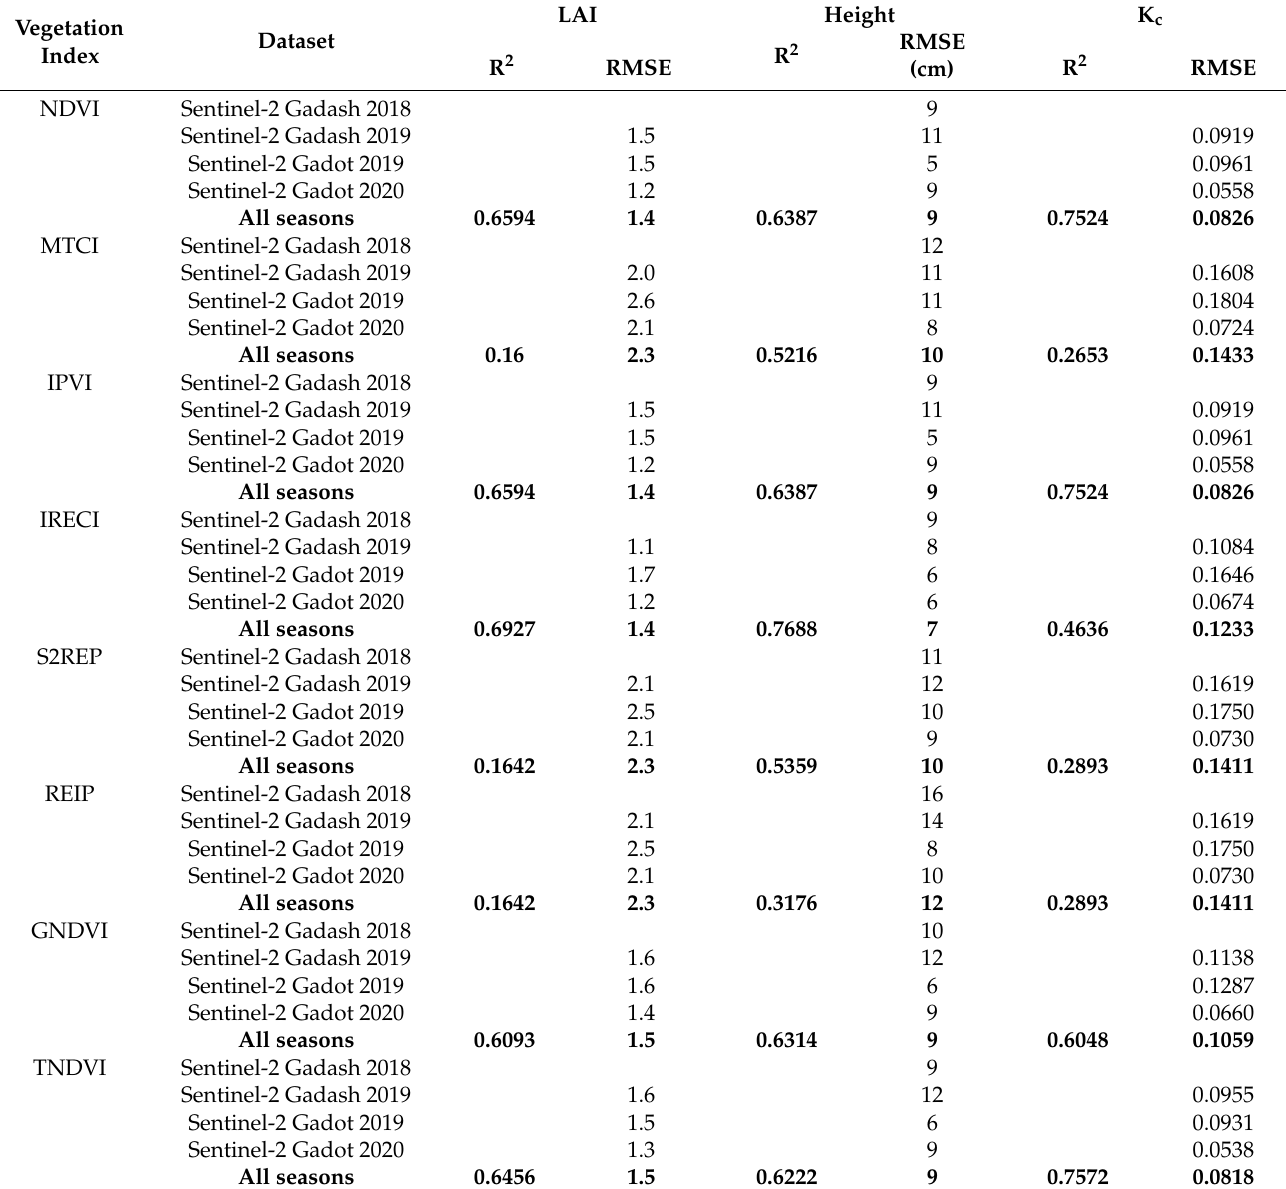
Table A2. Performance statistics of newly developed Sentinel-2-based LAI, Height, K c models, and the performance of the SNAP biophysical processor LAI estimation algorithm. Performance statistics of better performing VIs can be found in Table